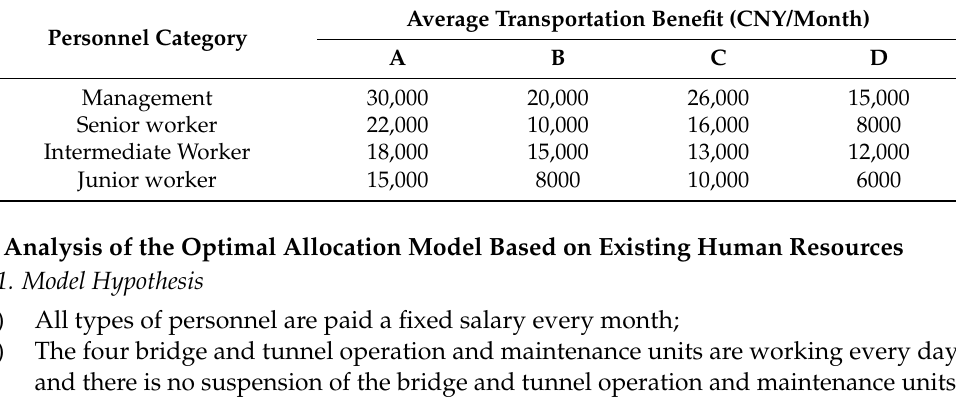
Table 2. Average transportation benefits of all types of